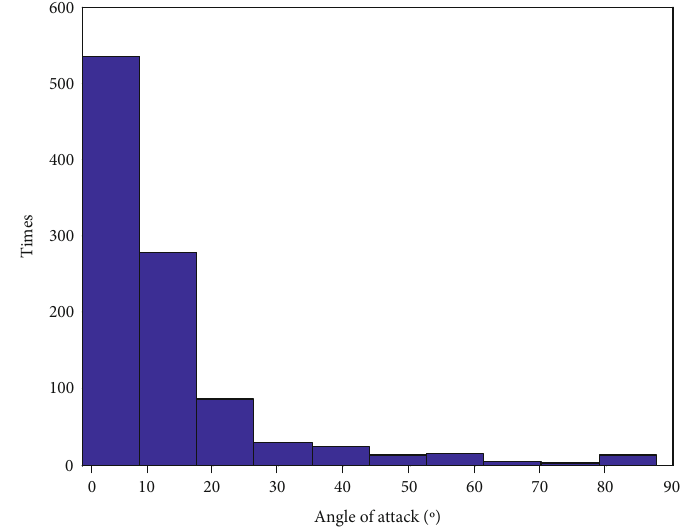
Figure 14: Angle of attack distribution histogram when the test parachute is ejected.